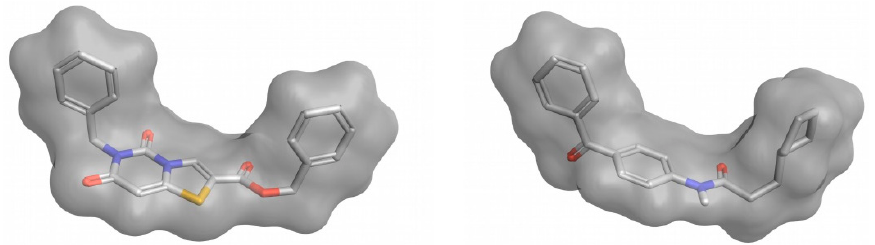
Figure 3. Example of two compounds with a different molecular structure but a high 3D-shape similarity. This figure was obtained with Flare [14].